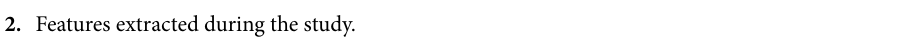
Table 2. Features extracted during the